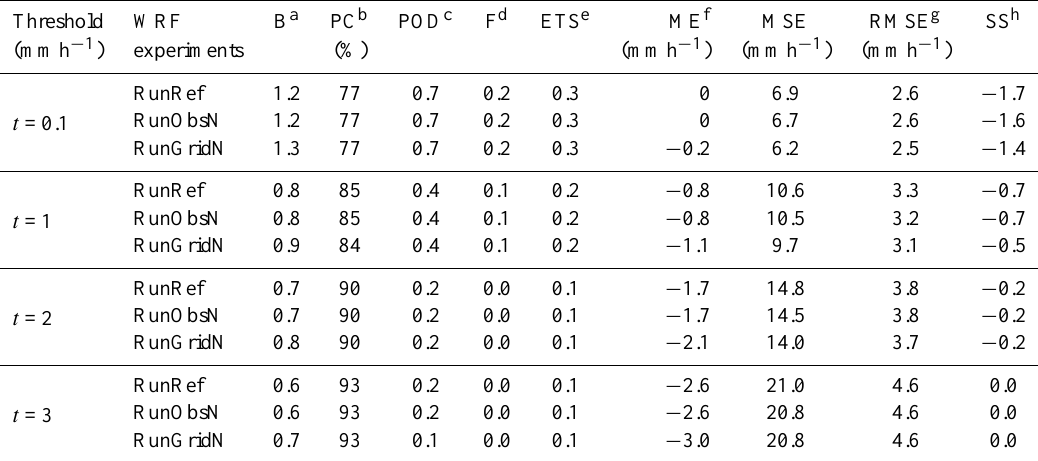
Table 7. Verification measures of hourly precipitation for the December 2009 evaluation period (745h of simulation) for the three WRF model experiments: RunRef, RunObsN and